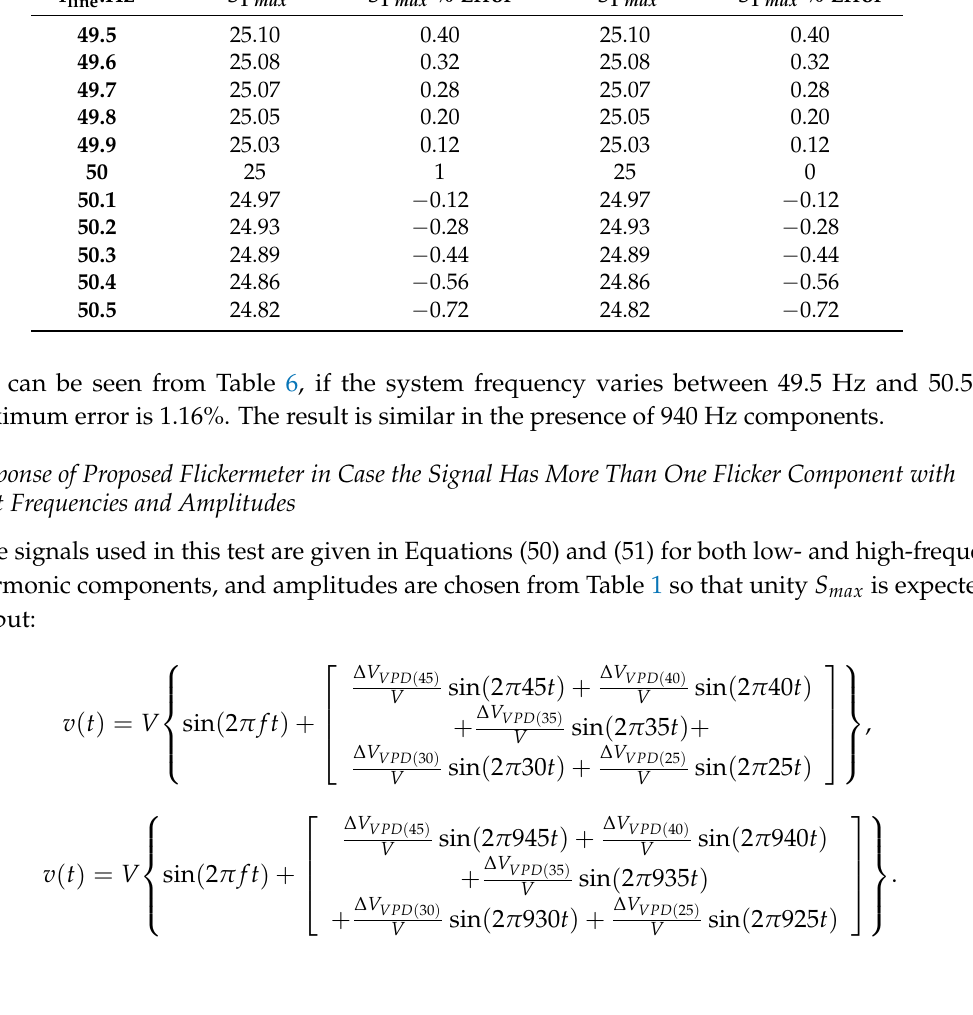
Table 6. Response of proposed flickermeter in the case of Equations (48) and (49). In the Case of a Signal with a In the Case of a Signal with a 40 Hz Interharmonic 940 Hz